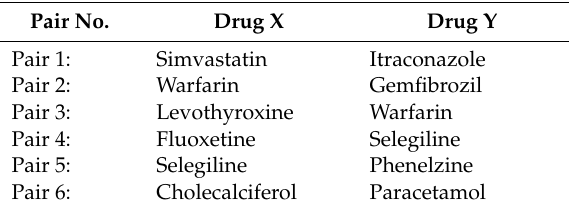
Table 2. Drug pairs applied in evaluated tasks.